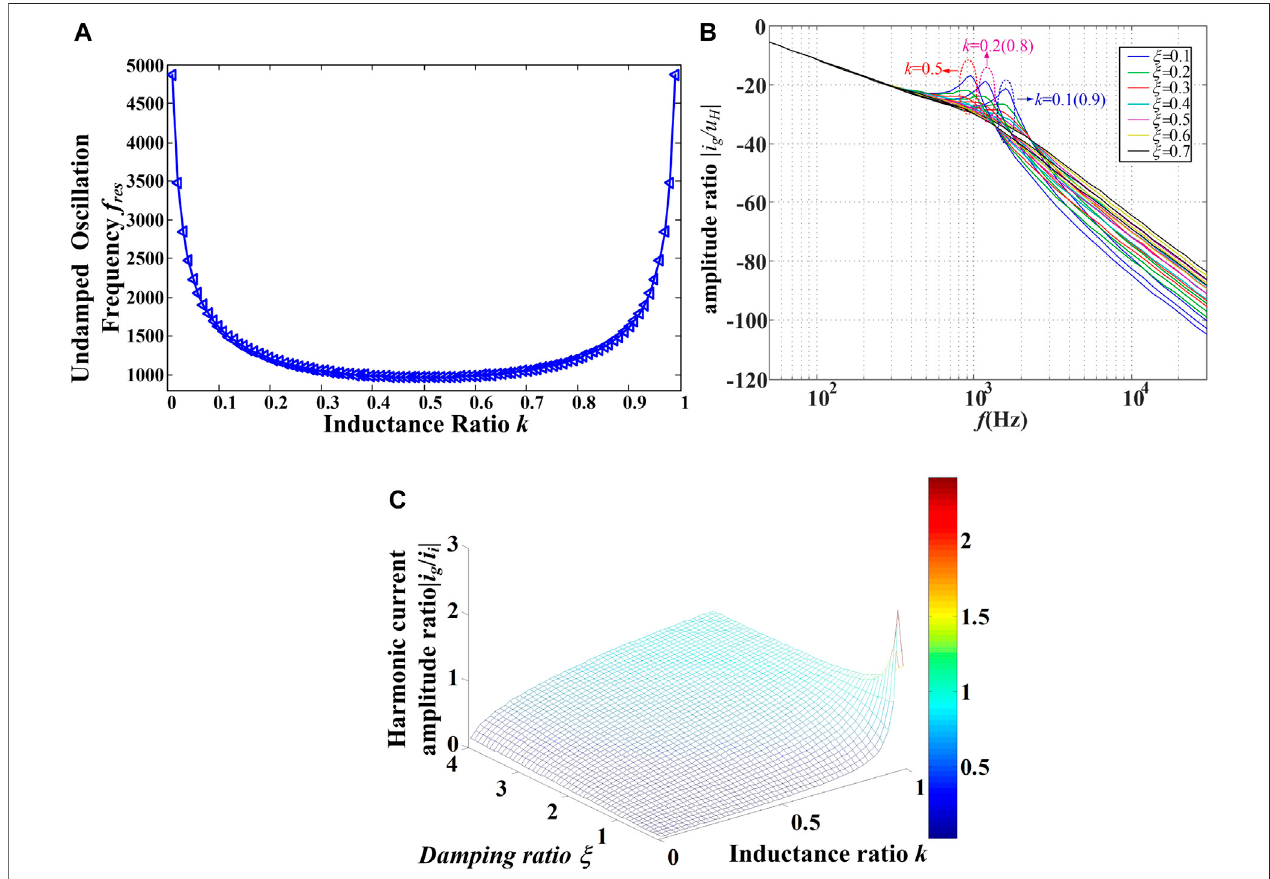
FIGURE 4 | Diagram of the relationship among different parameters. (A) undamped oscillation frequency f res and inductor ratio k . (B) Amplitude ratio | i g / u H | capacitors. (C) Amplitude ratio | i g / i i |.